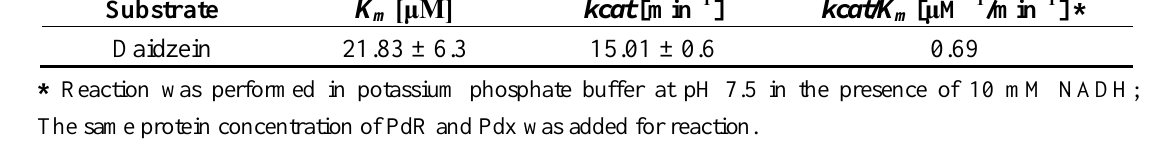
Table 1. Catalytic kinetic analysis for NADH-dependent hydroxylation of daidzein from CYP105D7.